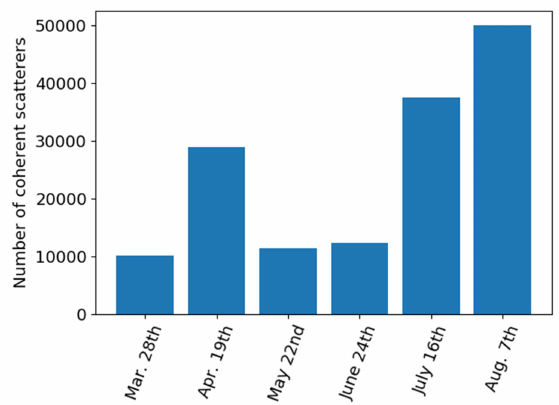
Figure 3. Number of detected coherent scatterers inside the Theresienwiese Park at different dates using repeat-pass